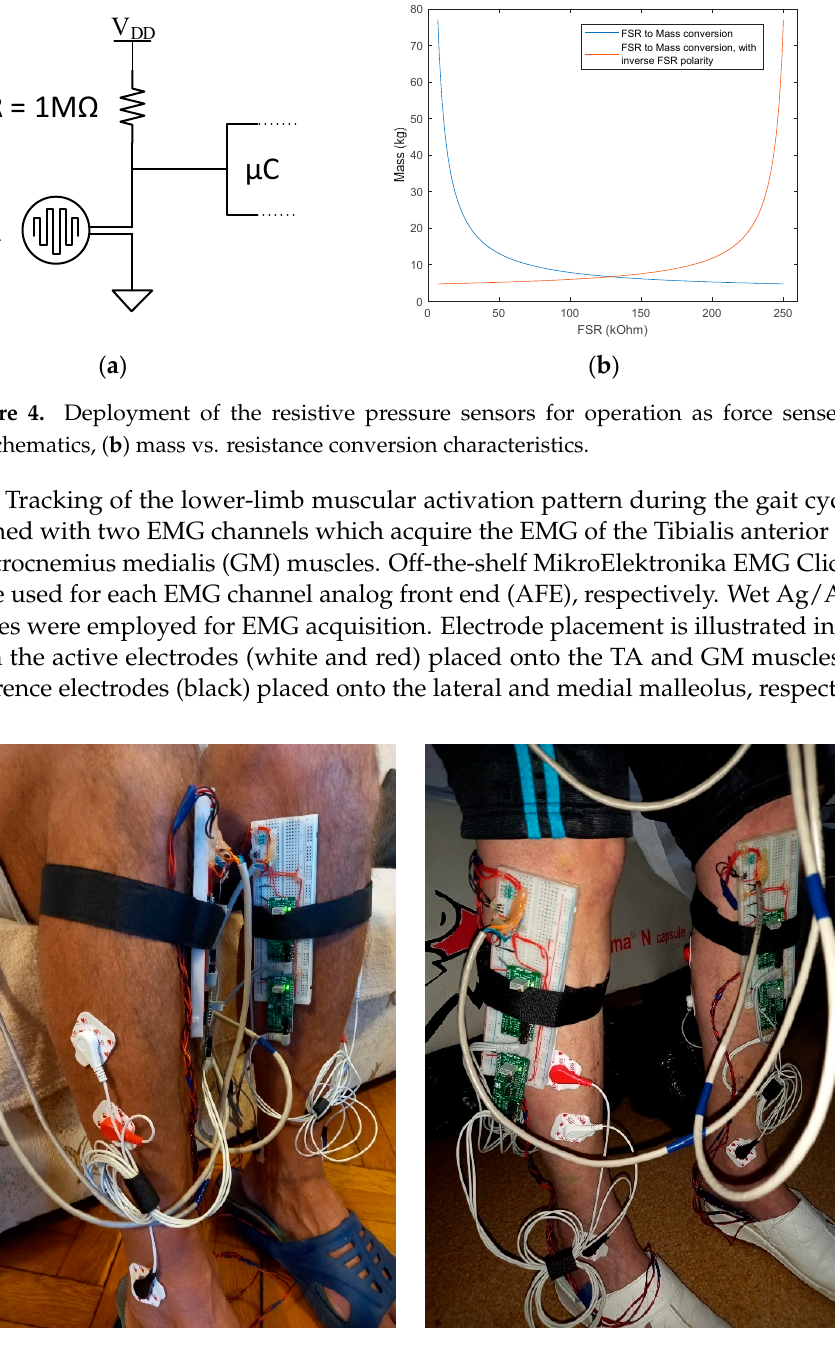
Figure 5. Illustration of the electrode placement for EMG acquisition of the Tibialis anterior and Gastrocnemius medialis, with the reference electrodes placed onto the lateral and medial malleolus, respectively.